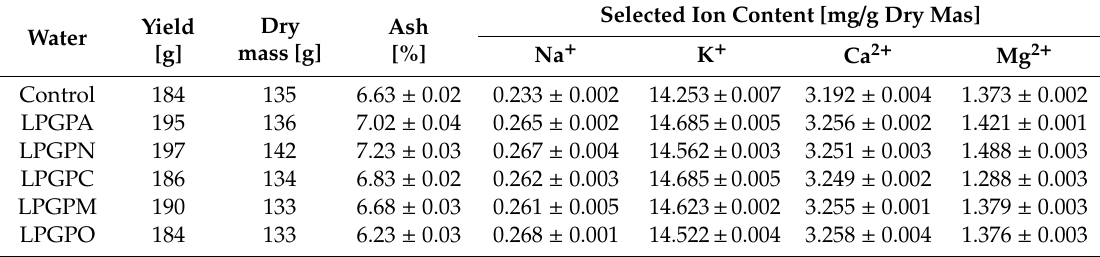
Table 1. Characteristics crops of L. angustofolia Mill. Results of watering plants with non-treated